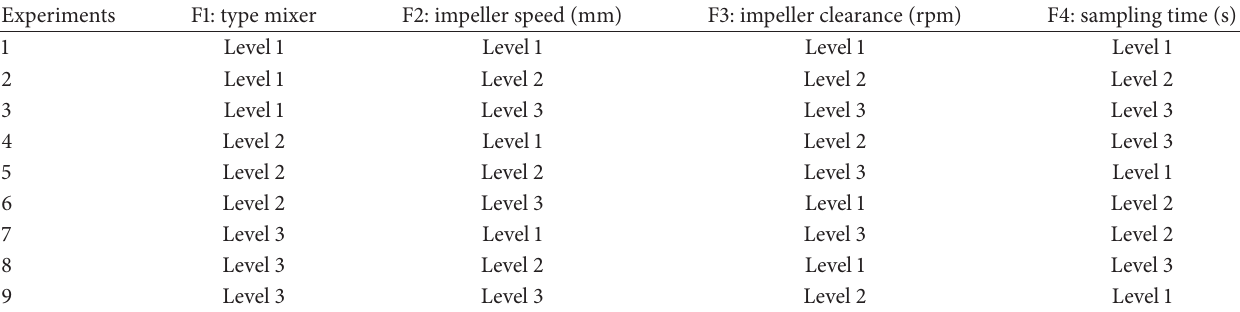
Table 3: The summarized results of MRT and 𝑉